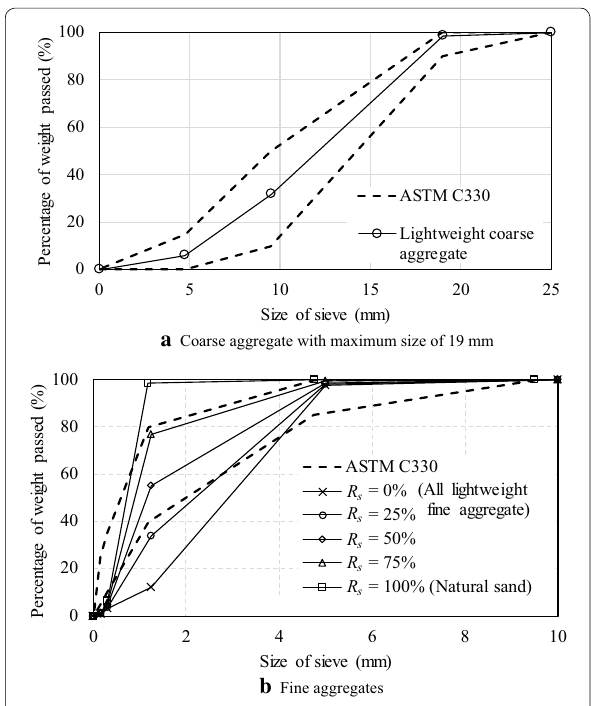
Fig. 3 Particle distribution curves of the aggregates used.